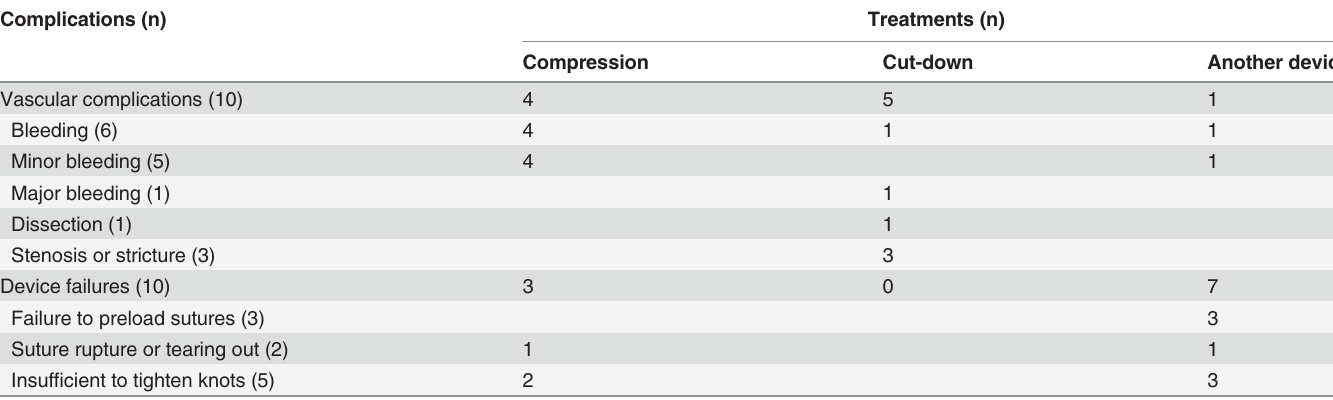
Table 2. Perclose Proglide related complications and treatments during pEVAR.